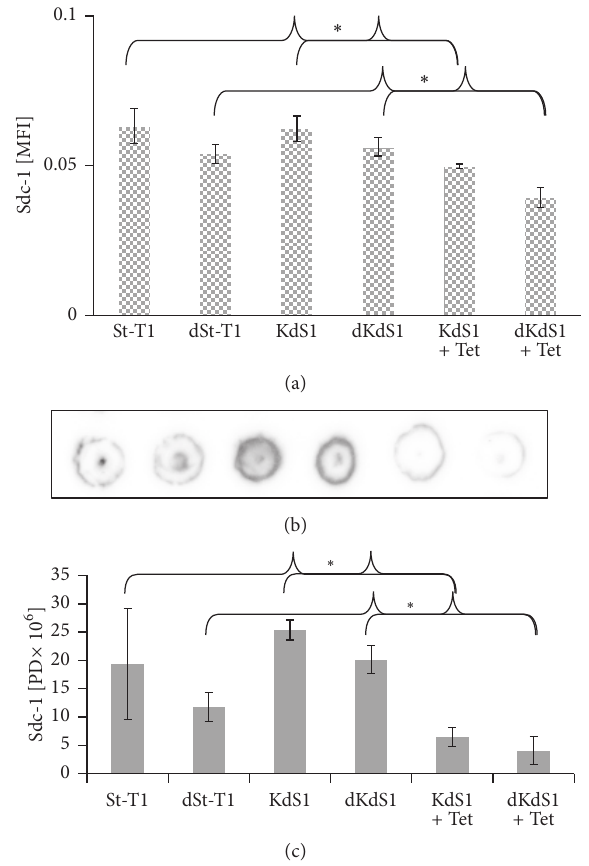
Figure 1: Evaluation of the Sdc-1 kd in the human EnS cell lines. (a) Sdc-1 mRNA levels determined by QGP assay [MFI = mean fluorescence intensity], the qualitative Sdc-1 protein expression was determined by dot blot analysis depicted in (b) and the corresponding pixel density evaluation is shown in (c) with and without decidualization (+/ − d) and with and without inducing the Sdc-1 kd (+/ − Tet) in KdS1 cells with 1 𝜇 g/mL Tet. The dot blot analysiswasperformedwith30 𝜇 gproteinperdot,andsampleswere applied in the same order as in (c). Data represent means ± SD with ∗ 𝑝 < 0.05 for Tet treated KdS1 cells versus untreated KdS1 (+/ − d)